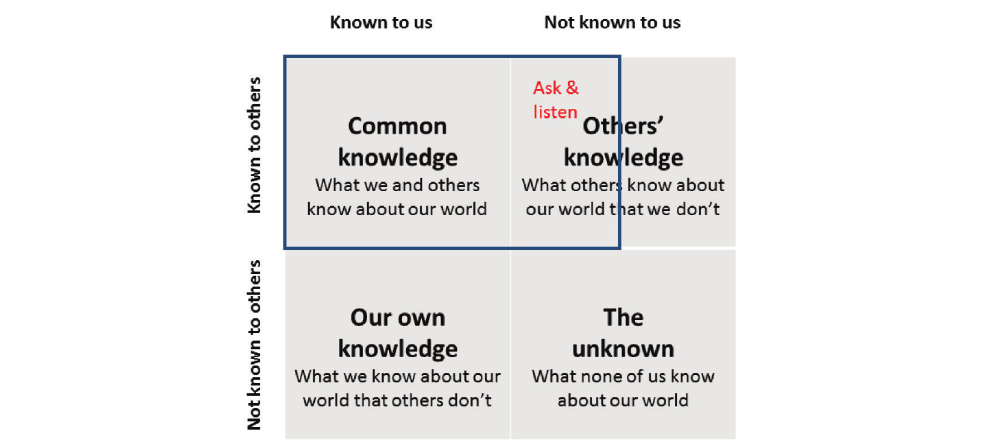
Figure 3: Seeking knowledge from